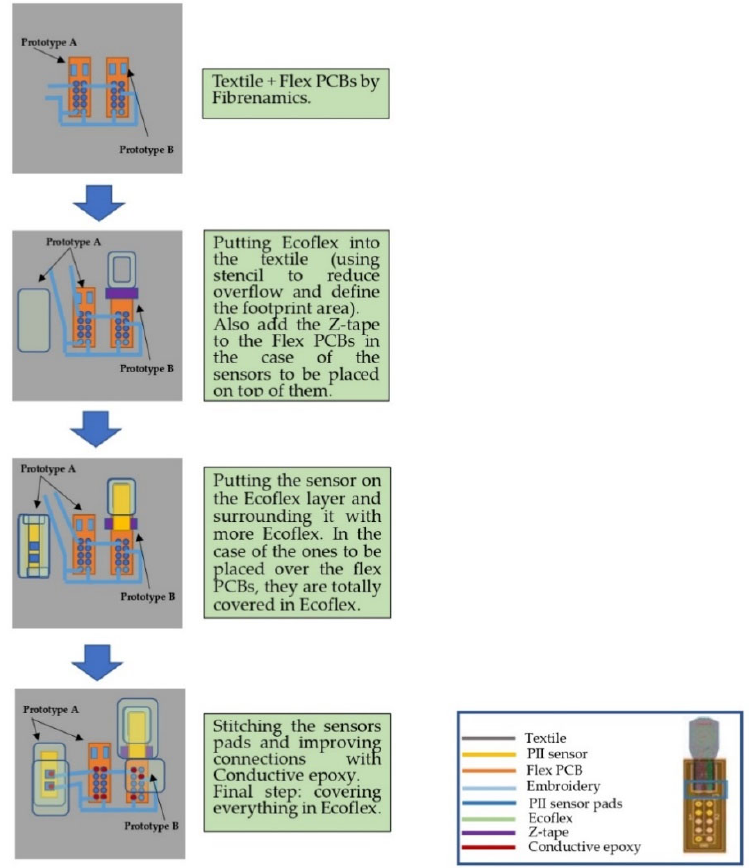
Figure 2. Integration of the temperature, pressure, and humidity sensors for expert evaluation of the physical and comfort aspects of the device. Coimbra, Portugal, 2022.